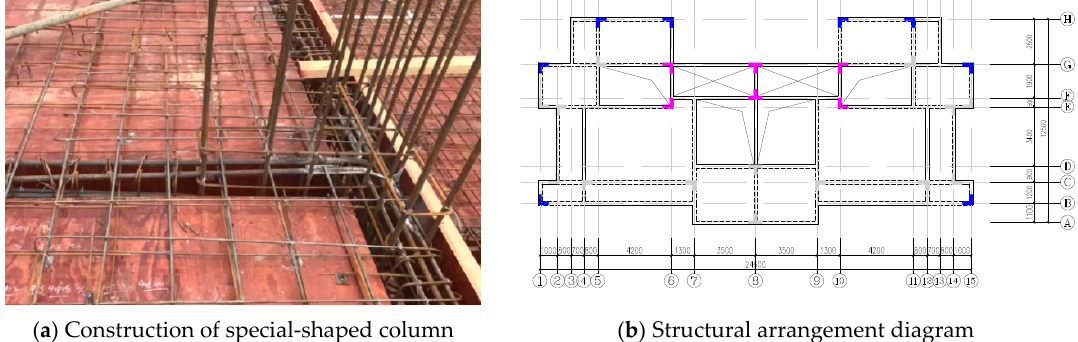
Figure 1. The special-shaped columns used in the practical engineering.